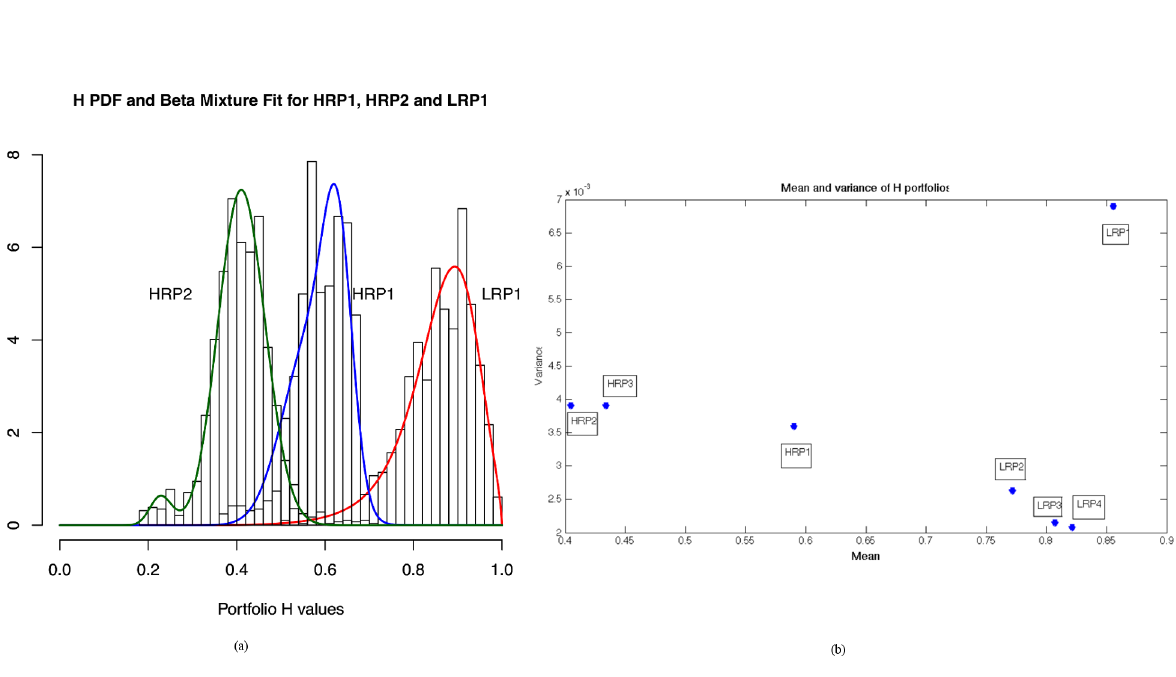
PLOS ONE | DOI:10.1371/journal.pone.0129471 June 18,